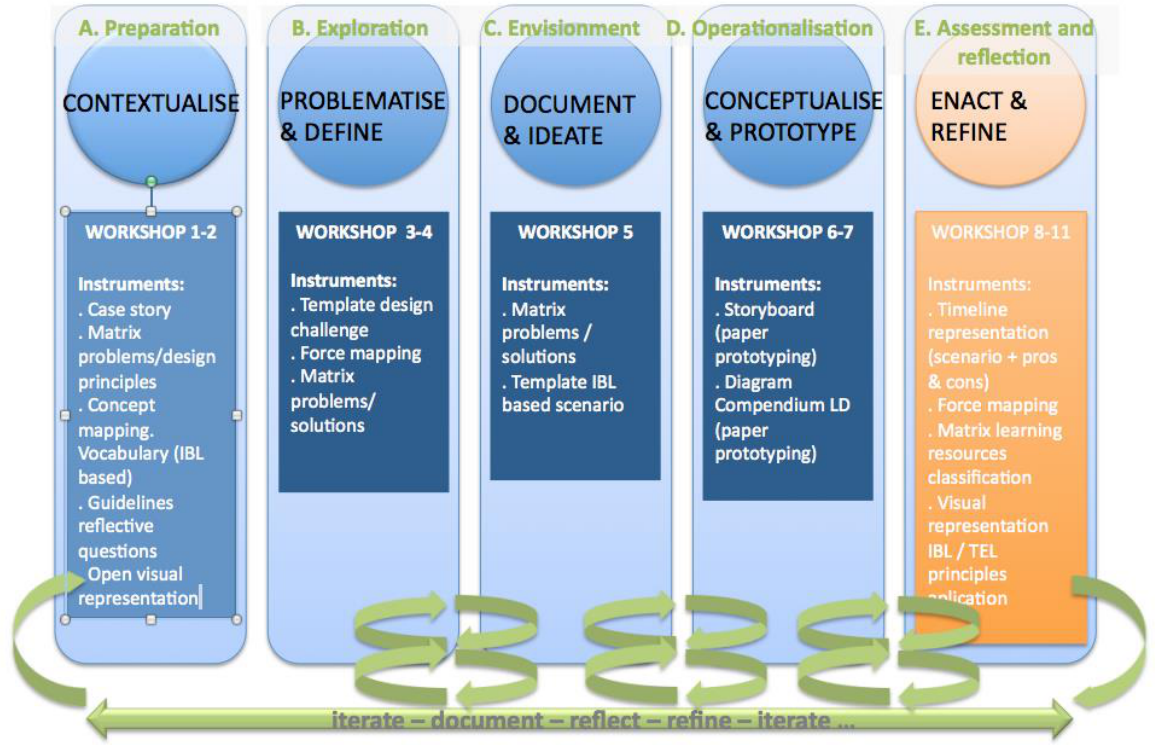
Figure 1. Co-design process embedded in a design-based research